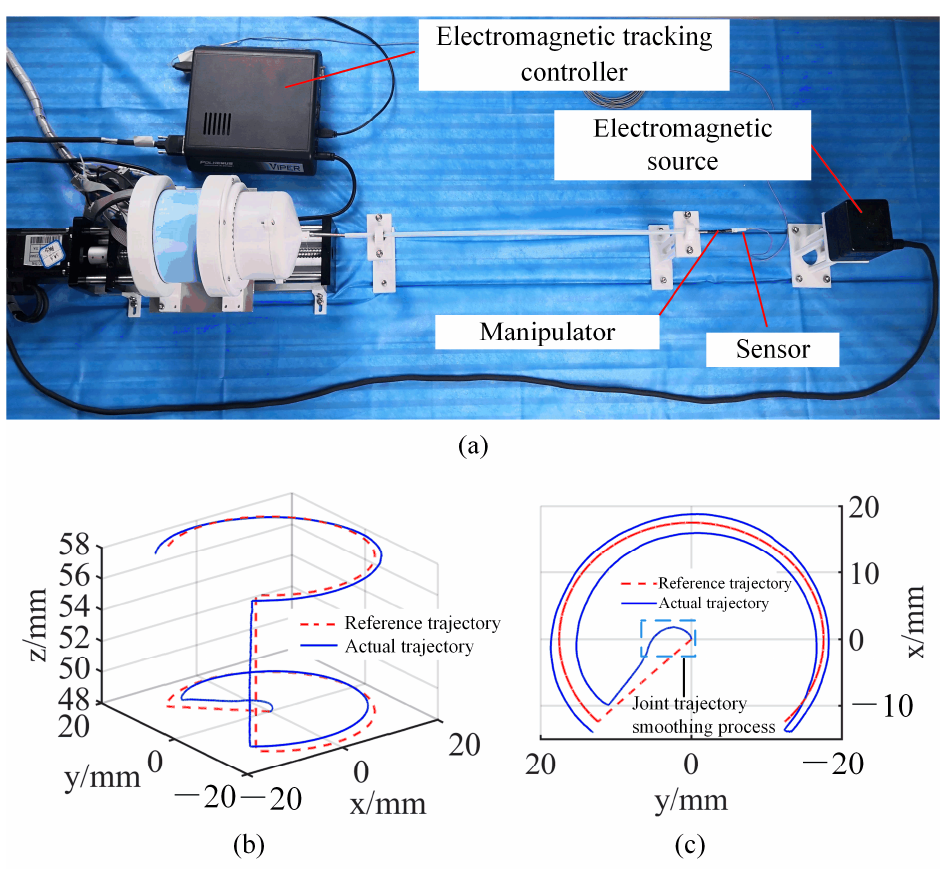
Figure 11. ( a ) Experimental setup of trajectory tracking; ( b ) isometric view of trajectory tracking; ( c ) top view of trajectory tracking.